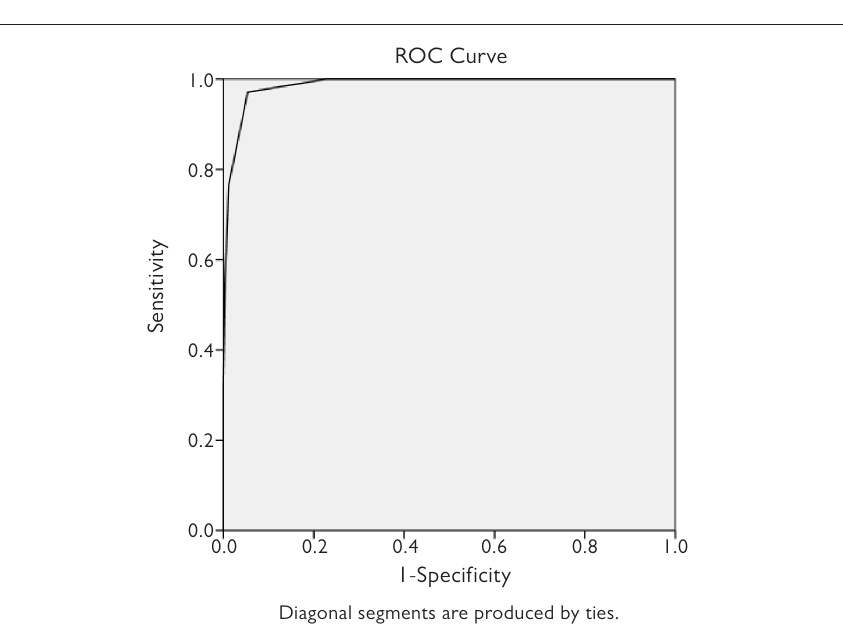
MACEDiagonal segments are produced Figure 2. ROC analysis for mHEART scores in predicting